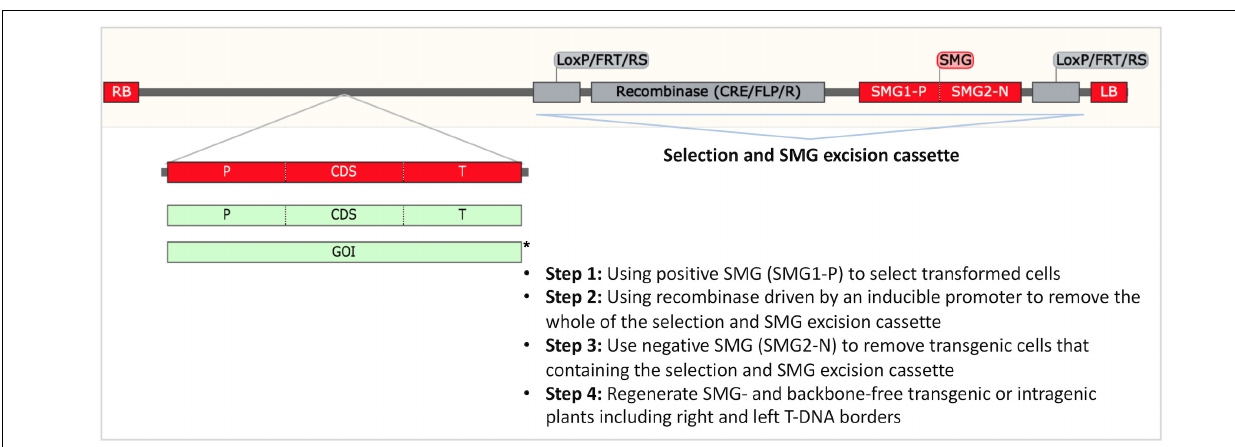
FIGURE 6 | Transgenesis without a SMG and intragenesis. A strategy to obtain SMG free and backbone free transgenic and intragenic F&N crops. The T-DNA region is drawn according to the construct used for intragenic apple (De Paepe et al., 2009; Kost et al., 2015; Collier et al., 2018). This construct allows production of SMG-free T 0 transformants. RB: right T-DNA border. LB: left T-DNA border. P: promoter. T: terminator. CDS: coding sequence. GOI: gene of interest. Green boxes show plant-derived intragenic/cisgenic components. ∗ Cisgenesis has not been demonstrated in A. tumefaciens -mediated transformation of plants because RB and LB are difficult to replace or